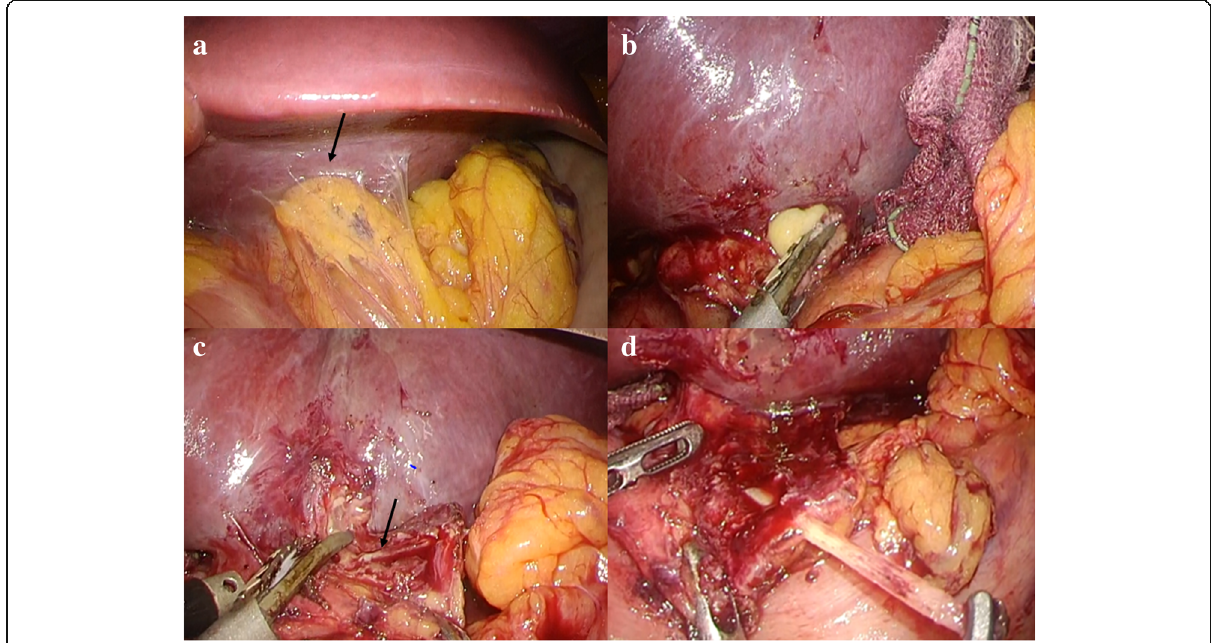
Fig. 3 Intraoperative findings. a Adhesions (black arrow) formed between the liver and reticulum. b Pus leakage from the adhesions between the liver and reticulum. c Fish bone (black arrow) embedded in the reticulum. d Fish bone removed successfully with laparoscopic surgery